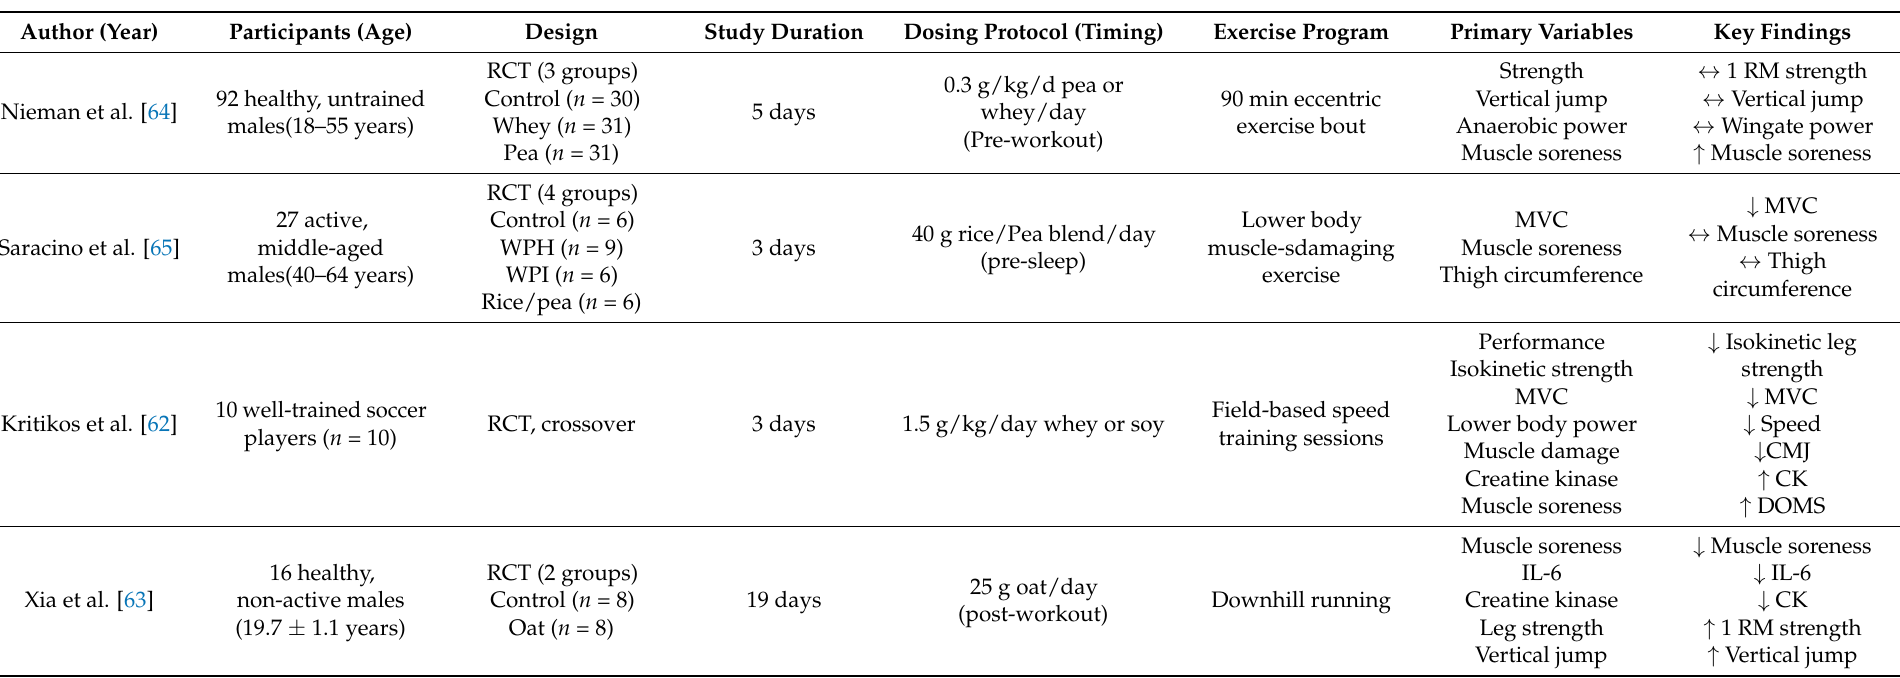
Table 3. Summary Table of Studies Examining Exercise Recovery Outcomes Using Plant Protein